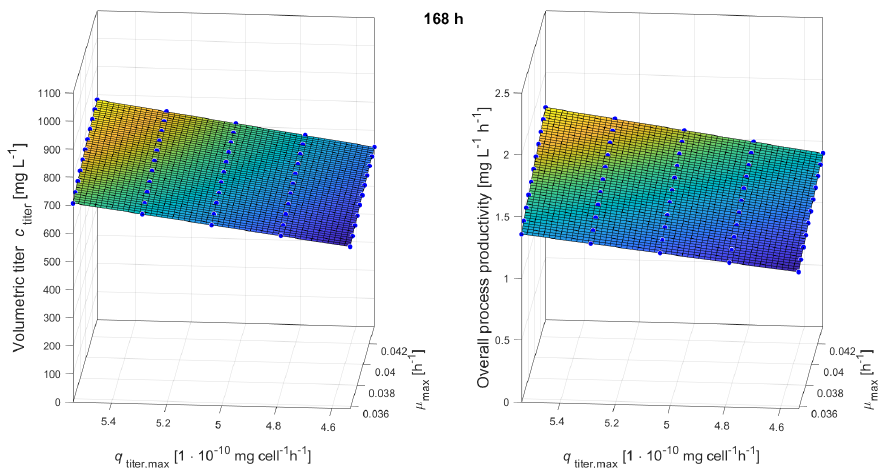
Figure A6. Response surfaces showing the impact of maximum growth rate and maximum production rate on volumetric titer and overall process productivity after 168 hours (7 days) in production.